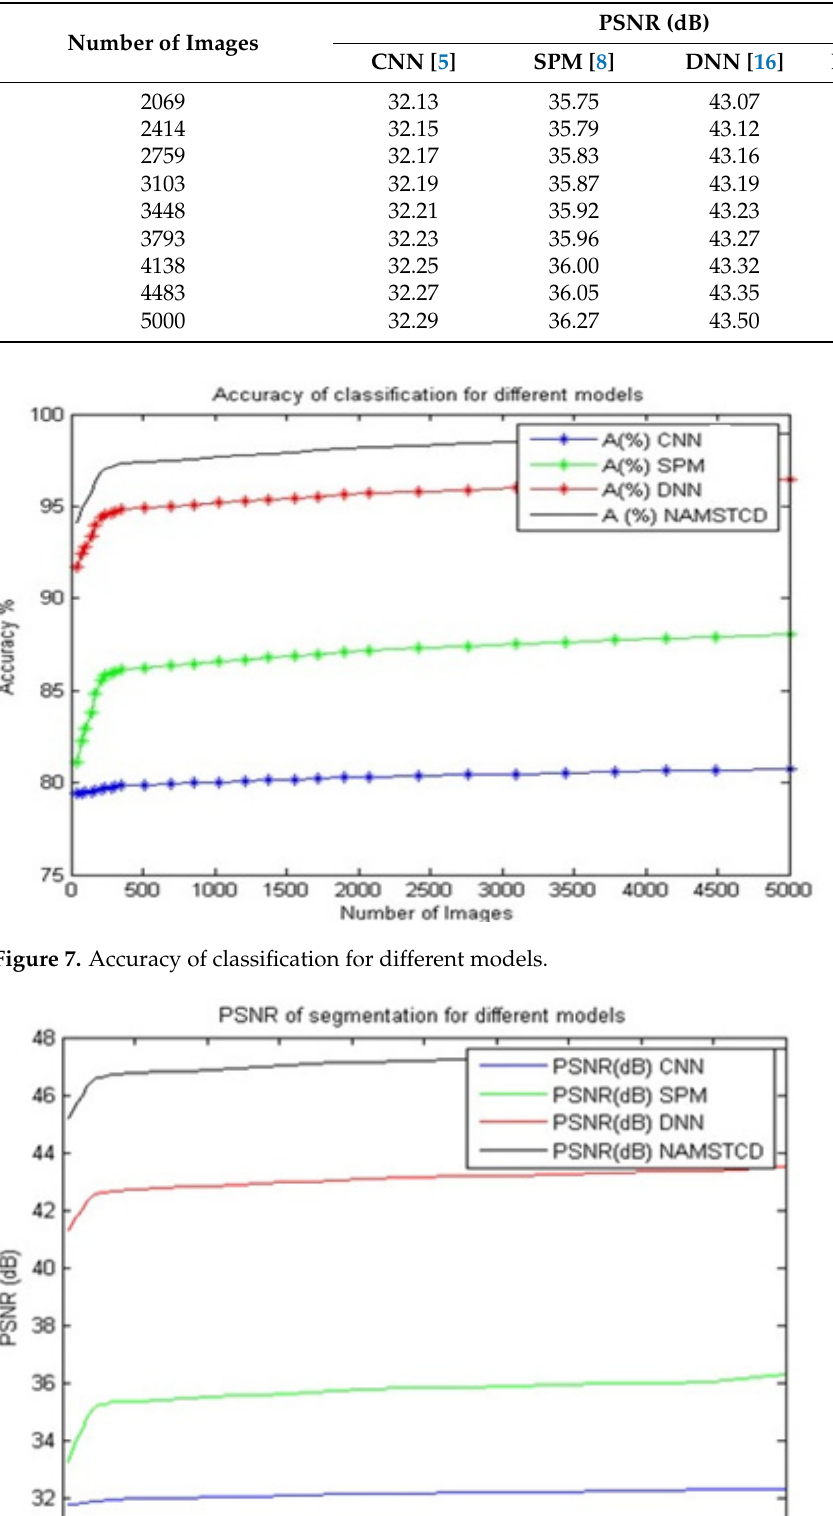
Table 4. Computational delay of di ff erent models. Number of Images